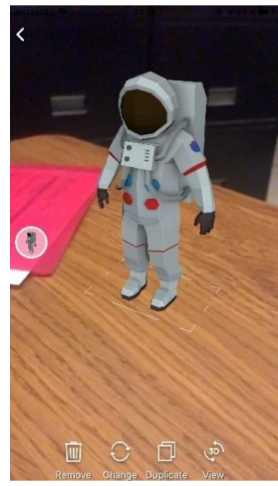
Figure 2. Augmented Reality (AR) image of the first part of the lesson for the AR